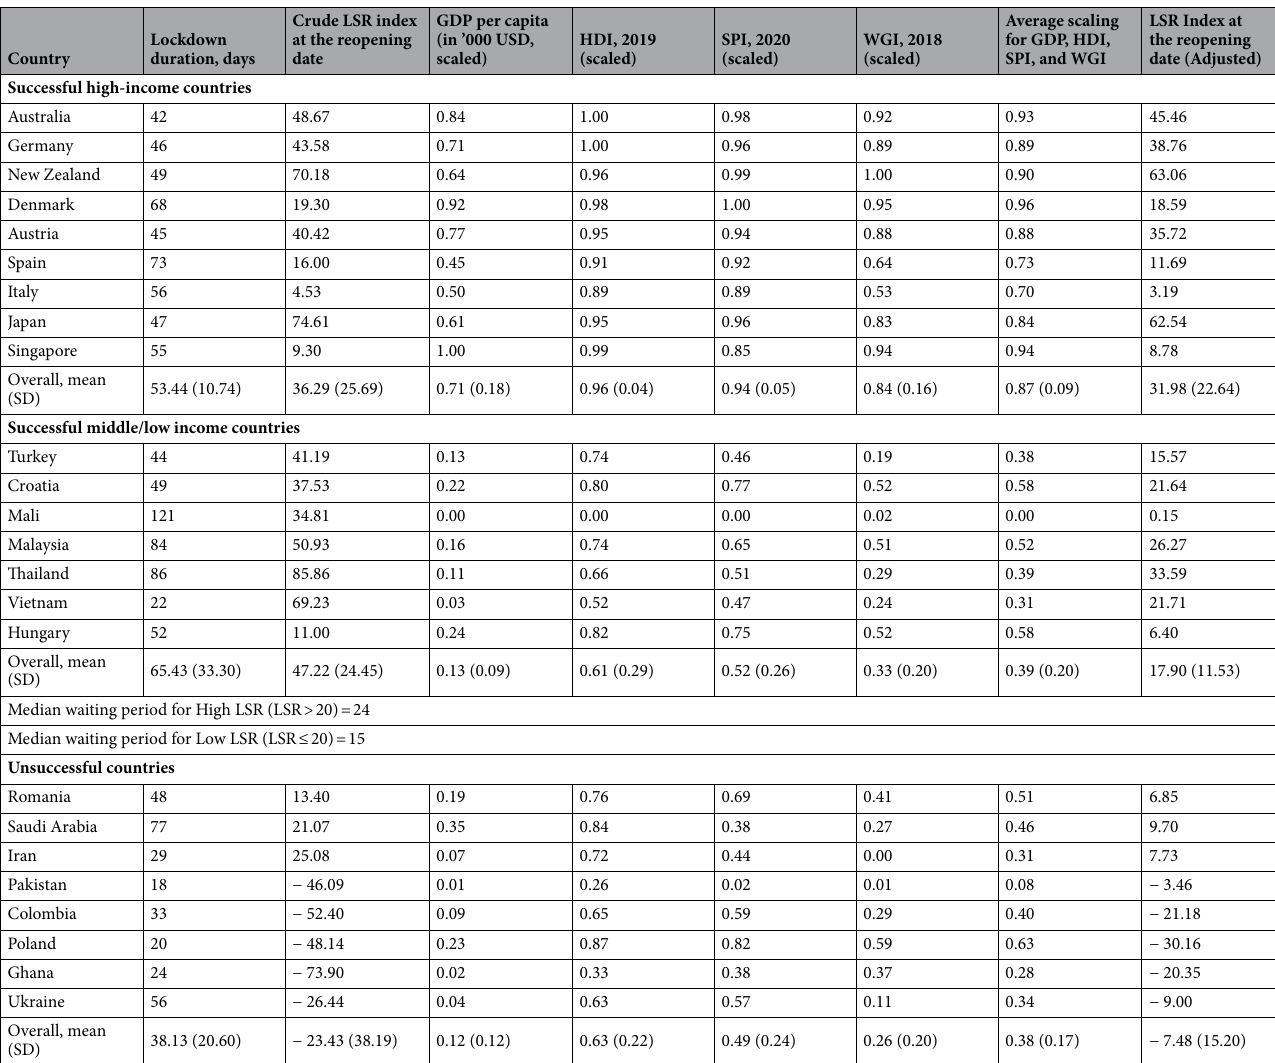
Table 3. Adjusted LSR index by country-specific socioeconomic and governance indicators. LSR large-scale reopening; HDI Human Development Index; SPI Social Progress Index; WGI World Governance Indicator; SD standard